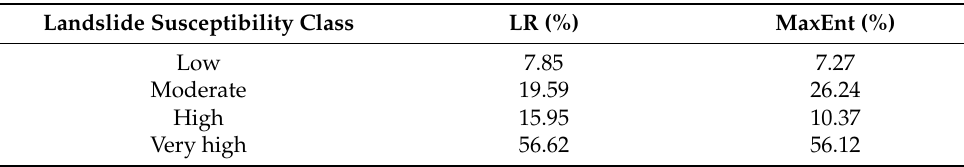
Figure 8. ROC curves of the models.